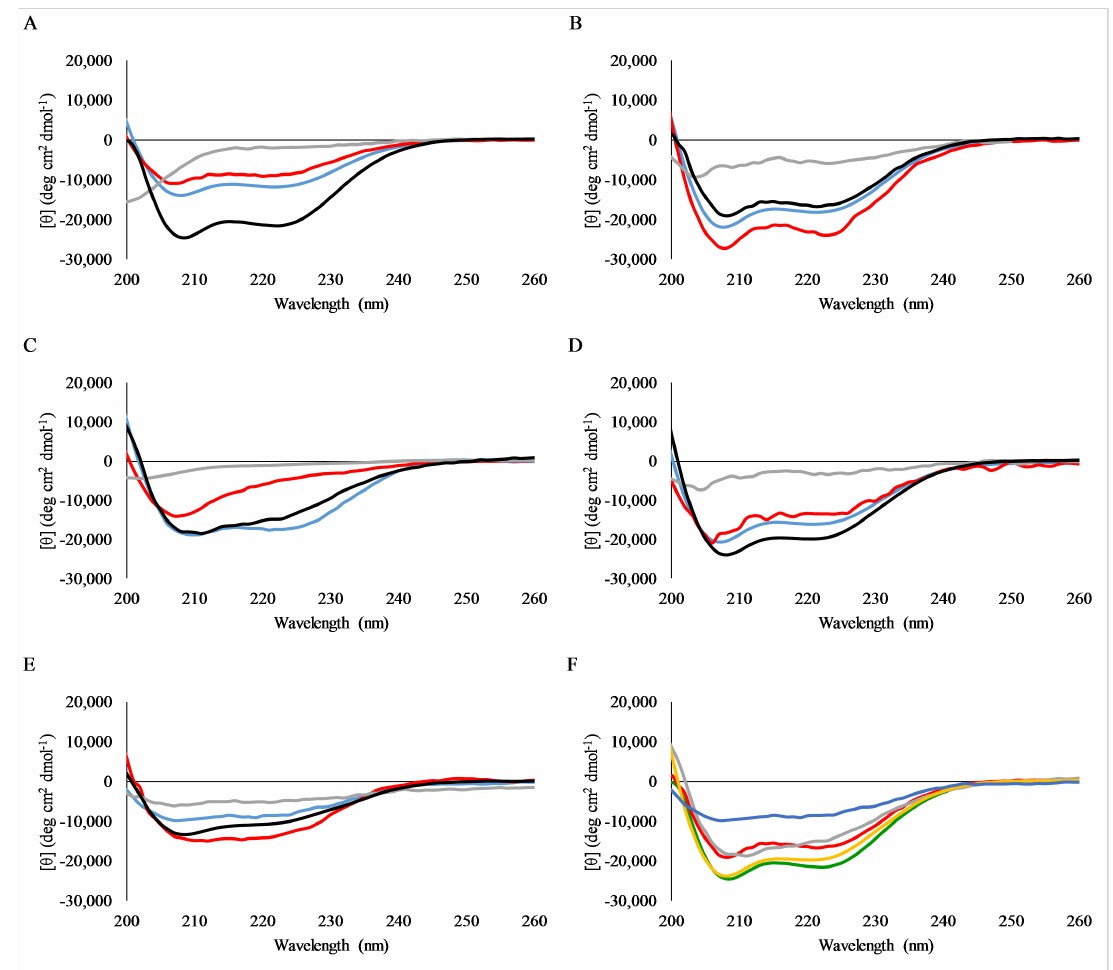
Figure 3. Circular dichroism spectra of peptides in varying environments. Spectra of samples containing 5 µM peptide in PBS (gray), 1:1 PBS/trifluoroethanol (red), 10 mM SDS in PBS (blue), or 3:1 PC/PG lipid vesicles (black) are shown in panels A–E: ( A ) C18G, ( B ) C18G-Arg, ( C ) C18G-His, ( D ) C18G-Orn, ( E ) C18G-Dap. ( F ) Comparison of all peptides when bound to lipid vesicles: C18G (green), C18G-Arg (red), C18G-His (gray), C18G-Orn (orange), C18G-Dap (blue). All data is the average of 64 scans, with background spectra subtracted.